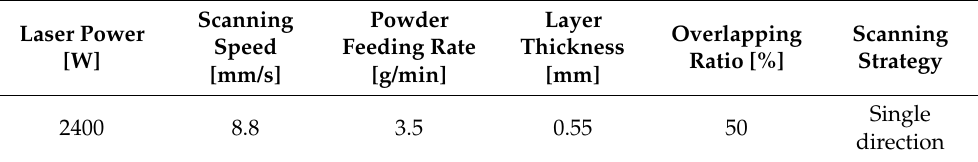
Table 2. The LMD processing parameters were used in the experiment. Figure 2. ( a ) Schematic diagrams of the LMD process; ( b ) sample location and build direction; ( c ) geometric size of the tensile specimen in mm.